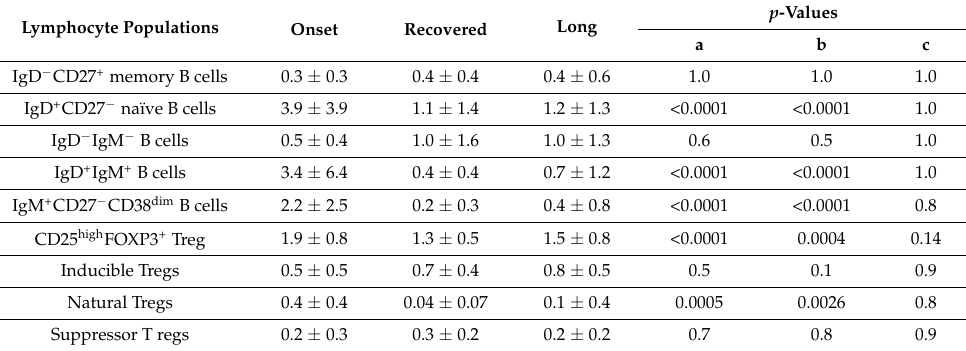
Figure 1. Peripheral blood B and Tregs subsets during the immunopathology of CoV2 infection. Two different panels of antibodies for B cells and Tregs subsets (Duraclone ® , Beckman Coulter, Pasadena, CA, USA) were used for staining. Gating strategy for the identification of cell subsets is described in [21]. Each circle represents the percentage of each cell population of the different patients/healthy subjects based on the indicated colors: CoV2 -infected children at onset of the disease (red circles), who recovered (green circles), with persistent symptoms (violet circles) and healthy subjects (white circles). The panel ( A ) displays the different distribution of B-cell subpopulations; panel ( B ) shows the percentages of Tregs subsets in the different groups. Symbols–or + were used to identify subpopulations with positive or negative markers, respectively, while “high” or “dim” indicate highly or moderately expressed markers respectively. A two-way ANOVA corrected with Tukey were used to statistically examine the data. Table 2. B and Tregs populations comparisons. The data refers to Figure 1 extracted percentages (mean ± standard deviation), excluding controls, and p values were calculated applying two-way ANOVA corrected with Tukey: a: comparison among Onset and recovered children; b: comparison among onset and long; and c: comparison among long and